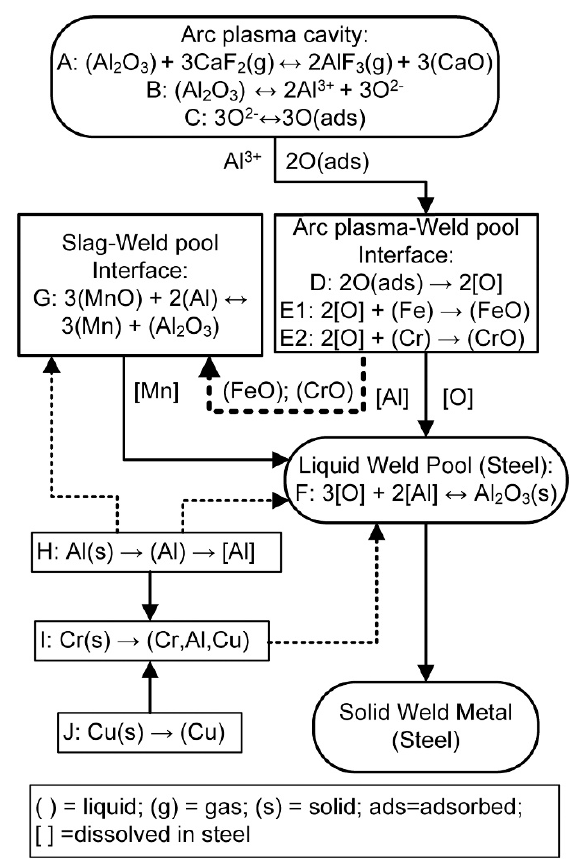
Figure 9. SAW reaction flow diagram with Al, Cr, and Cu powder addition reactions.